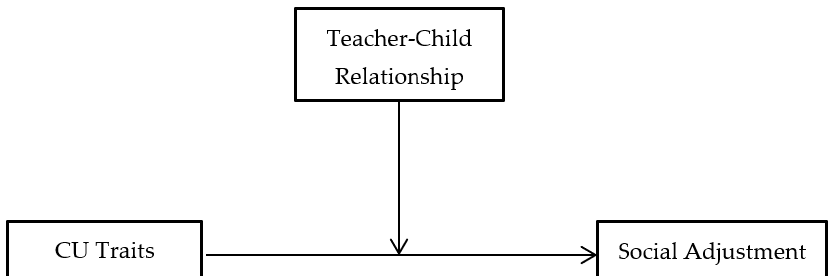
Figure 1. The hypothesized model.